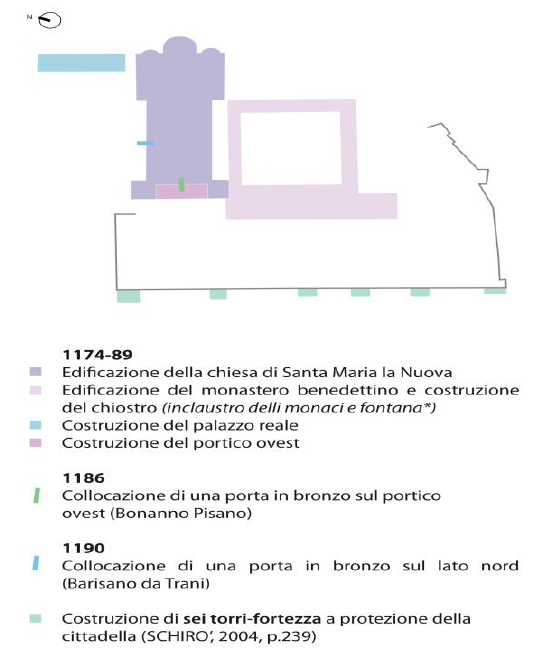
Figure 10. Original plant of Maredolce site (Di Franco, P. for